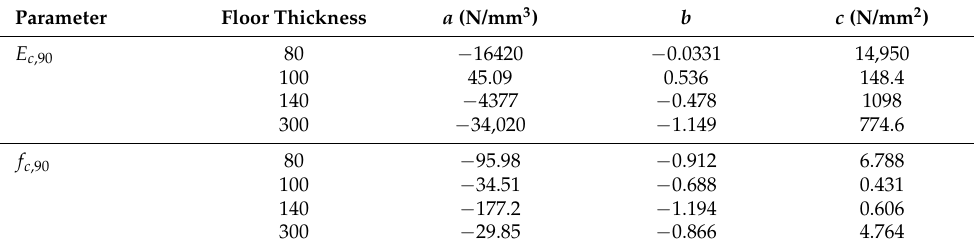
Table 8. Coefficients of regression curves shown in Figure 12c,d according to Equation (9) for E c ,90 and f c ,90 as a function of floor thickness, t f